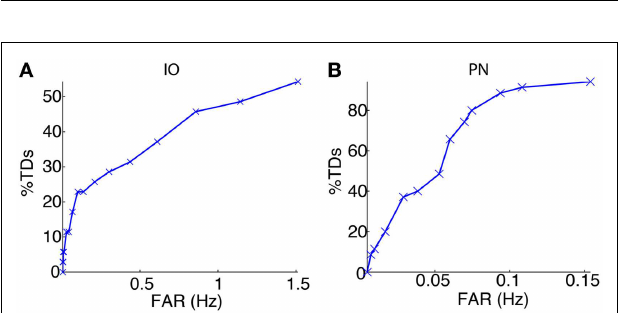
it does when the latency of the NOI is properly set ( Figure 6B ).